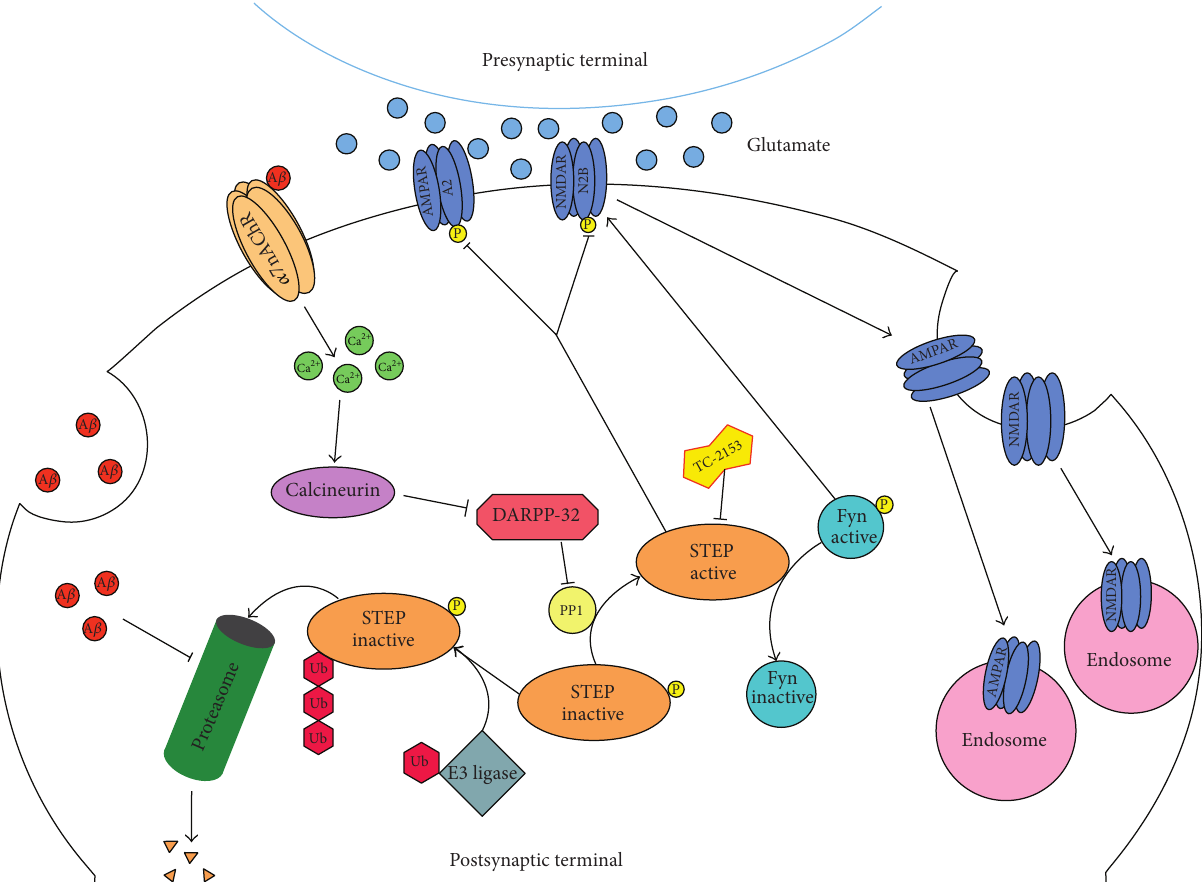
Figure 1: STEP signaling pathways associated with Alzheimer’s disease. The binding of A 𝛽 to 𝛼 7nAChRs results in activation of calcineurin (PP2B), inhibition of DARPP-32, and activation of PP1. PP1 dephosphorylates STEP 61 at a regulatory serine within the substrate-binding domain (Ser 221 ). Dephosphorylation of this serine residue increases the affinity of STEP for its substrates. In a parallel pathway, A 𝛽 inhibits the proteasome, thereby blocking the degradation of STEP 61 . Both mechanisms result in an accumulation of active STEP 61 . The increase in active STEP 61 results in increased dephosphorylation of GluN2B Tyr 1472 and internalization of GluN2B-containing NMDARs. In addition, dephosphorylation of Fyn results in its inactivation. Thus, active STEP 61 directly dephosphorylates GluN2B and at the same time inactivates the kinase that phosphorylates STEP 61 at Tyr 1472